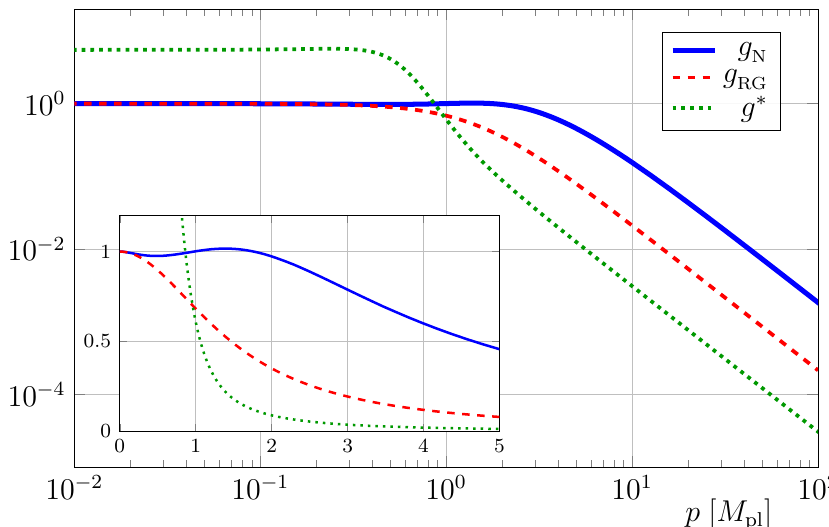
( p ) = G ( p ) M 2 as a function of momentum N N pl = g ( p = 0 ) (red, dashed) as a function of k = p , RG k